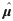
Comparison of μ^ across departments, journals, and researchers.We show the maximum likelihood fitted μ^ for chemistry departments and chemistry journals in select years, and for all chemistry researchers in our database. The black horizontal dashed lines mark the value of the corresponding parameter for the Journal of the American Chemical Society in 1995. For clarity, we do not show μ^ for 23 journals that are outliers.